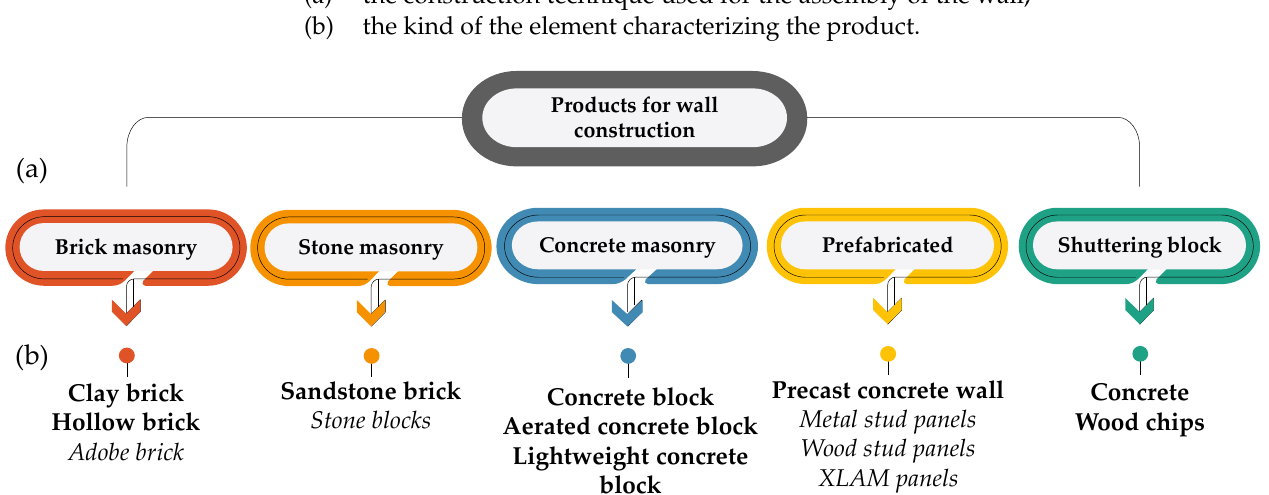
Figure 1. Classification of products for wall construction (those in italic are not considered in this study). ( a ) Construction technique, ( b ) construction element/product.